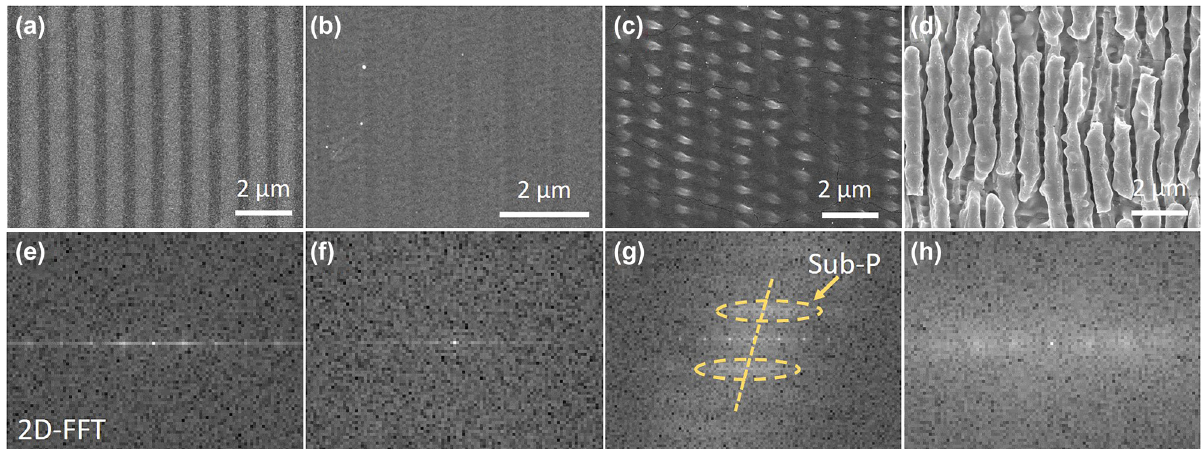
Figure 2: SEM images of the characteristic structures formed during the morphological evolution of GST under irradiation by increasing laser energy. (a) 62.4, (b) 91.2, (c) 155.6, and (d) 173.5 nJ, the scanning speed was fixed at 500 μ m/s. Figures (e)–(h) depict the 2D-FFT of the SEM images shown in (a)–(d),